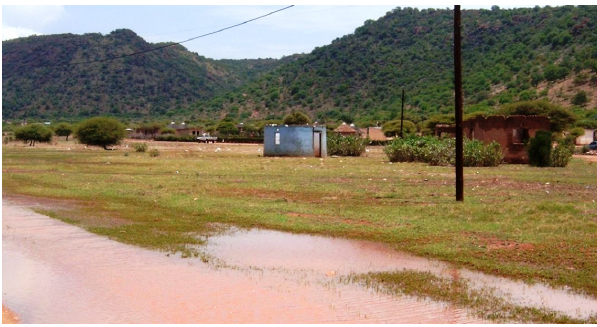
Figure 9. Abandoned houses in the Shoshong floodplain (photo- grapher: Mpho,